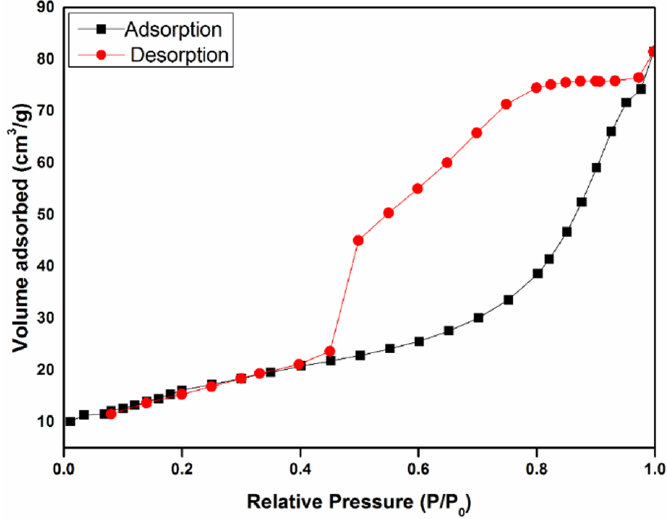
Figure 4. N 2 adsorption–desorption isotherms of Fe/CA.